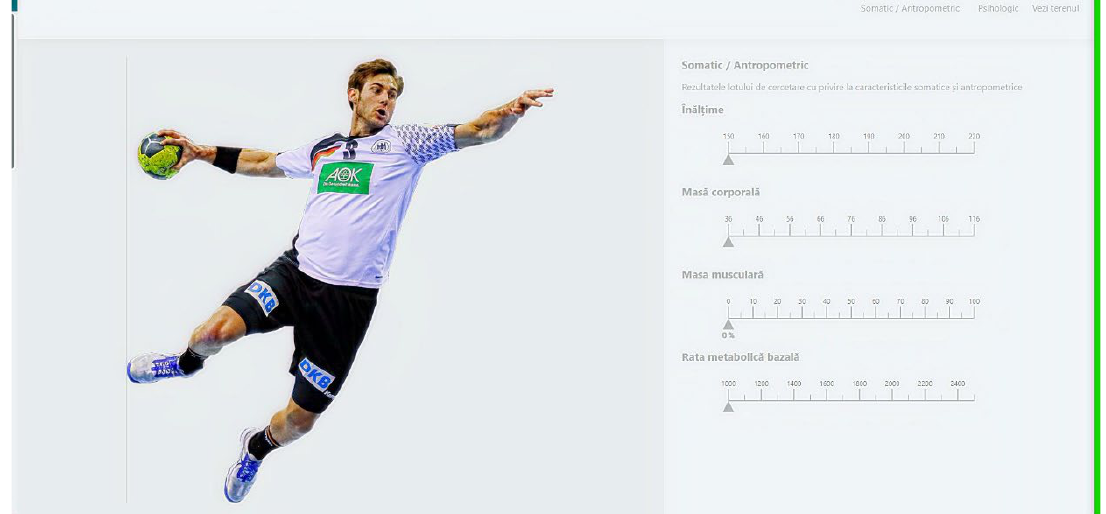
Figure 3. Representation of the software’s third page.